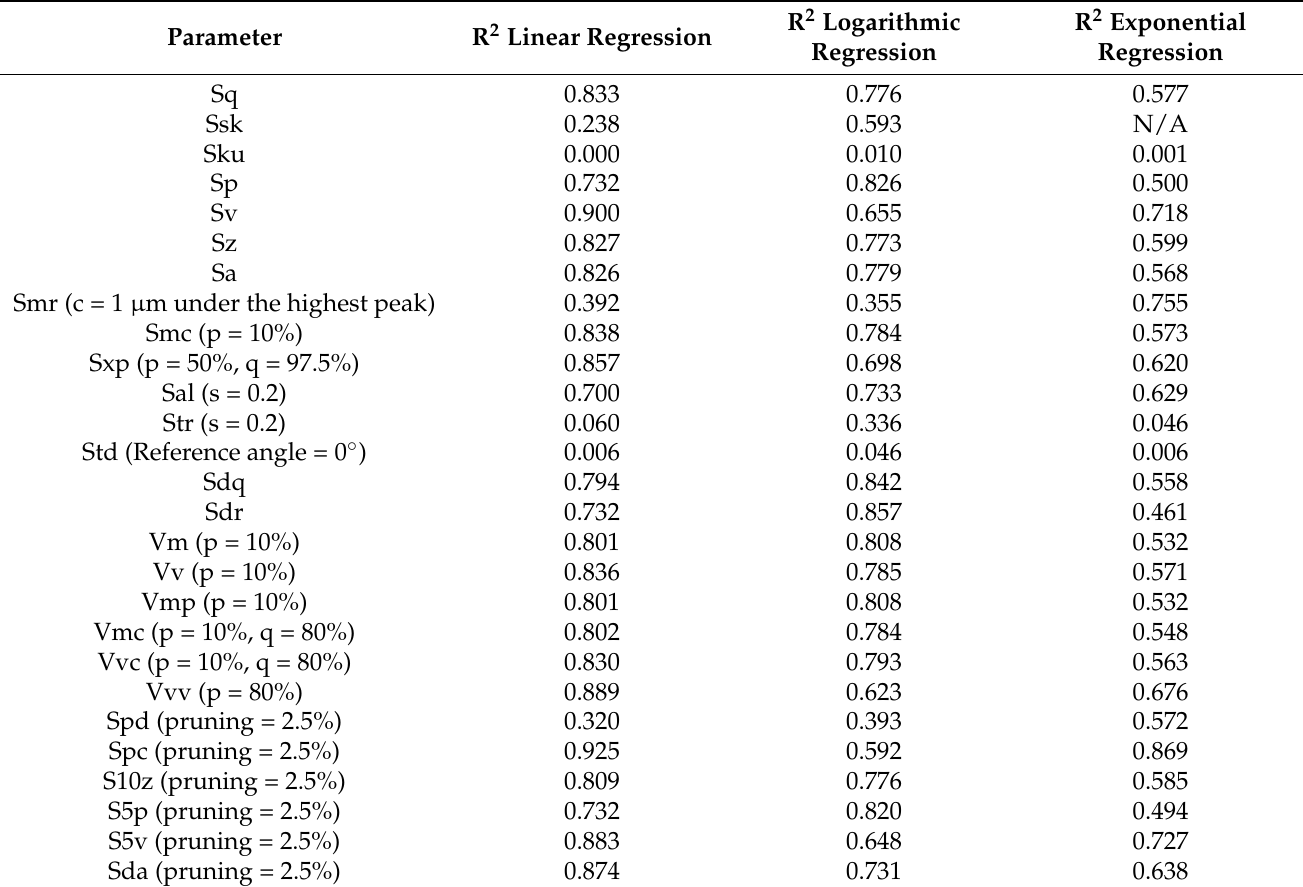
Table 2. Coefficient of determination R 2 calculated for linear, logarithmic and exponential regression between areal characterization parameters and the discharge